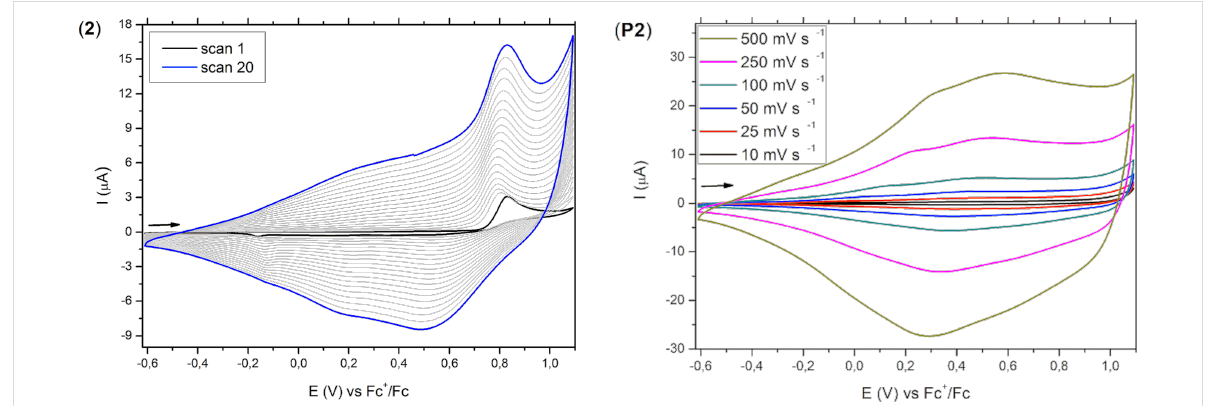
Figure 8: Multisweep voltammograms for the electrochemical polymerization of monomeric heterotriacene DST 2 in CH 2 Cl 2 /TBAPF 6 (0.1 M) at a scan rate of 100 mV s − 1 (left) and electrochemical characterization of the corresponding polymer P(DTS) P2 in CH 2 Cl 2 /TBAPF 6 (0.1 M) using differ- ent scan rates